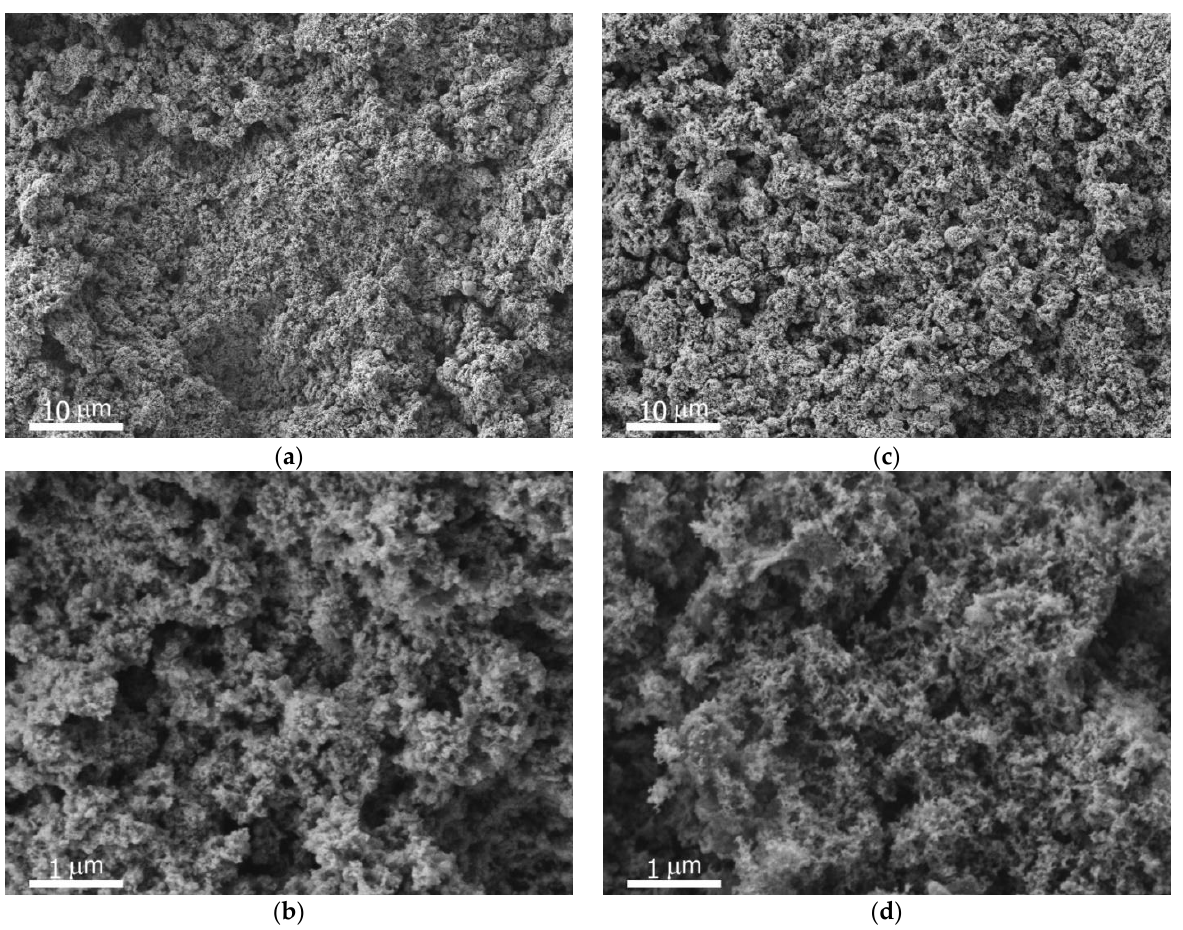
Figure 1. Typical SEM images of the superhydrophobic surface of MA8 alloy at two different magnifications before ( a , b ) and after ( c , d ) contact with 0.5 M NaCl solution.